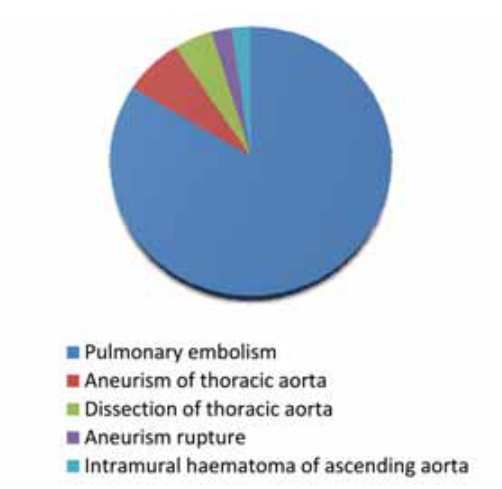
FIGURE 1. Number of diagnosis (n=43), MSCT results with potentially lethal